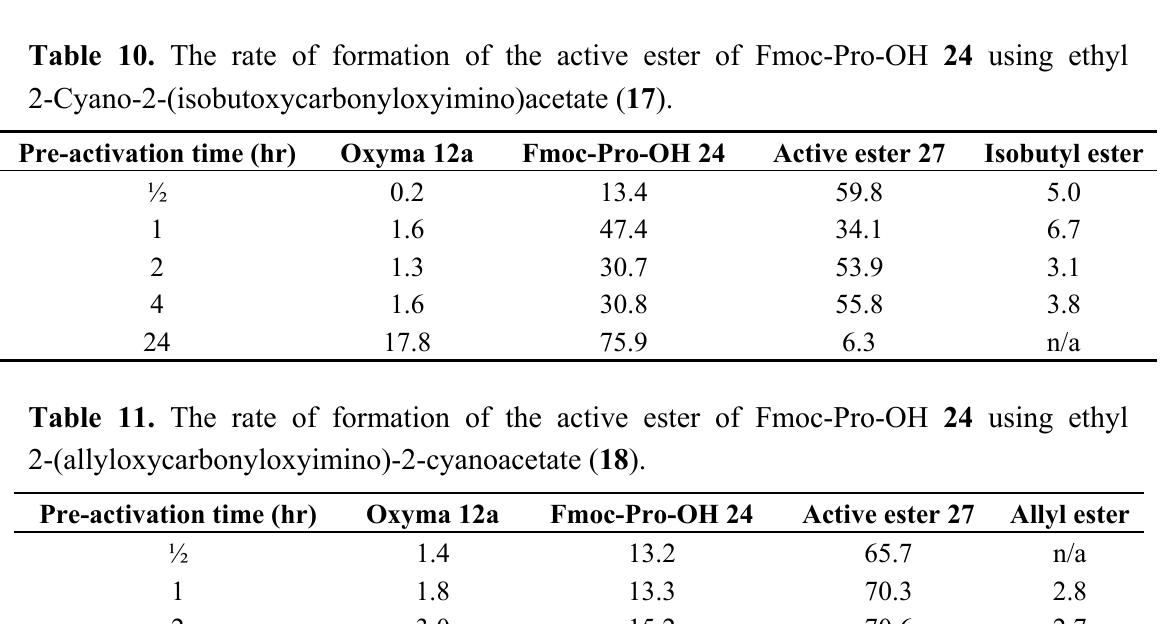
Table 10. The rate of formation of the active ester of Fmoc-Pro-OH 24 using ethyl